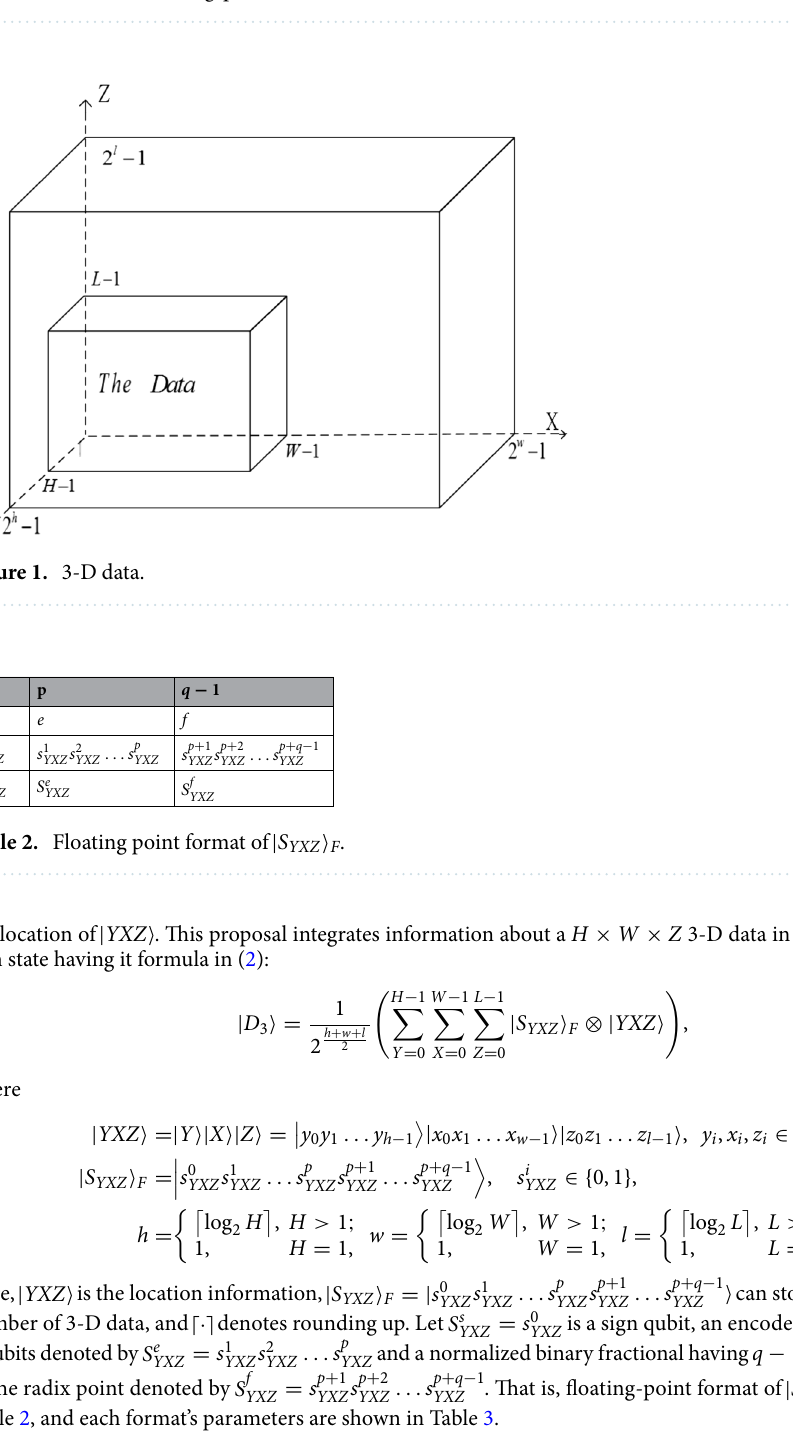
Table 1. Format of floating-point numbers in IEEE-754.